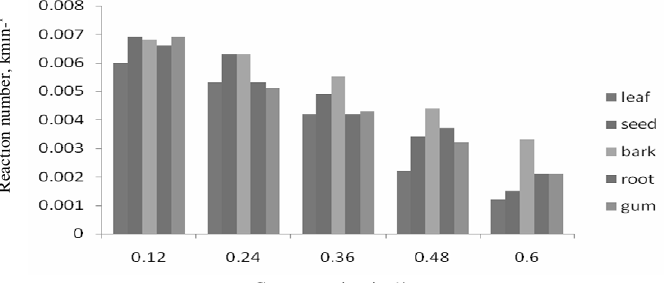
Figure 6. Variation of reaction number vs. Concentration with all five inhibitors in 2 N hydrochloric acid solution in mild